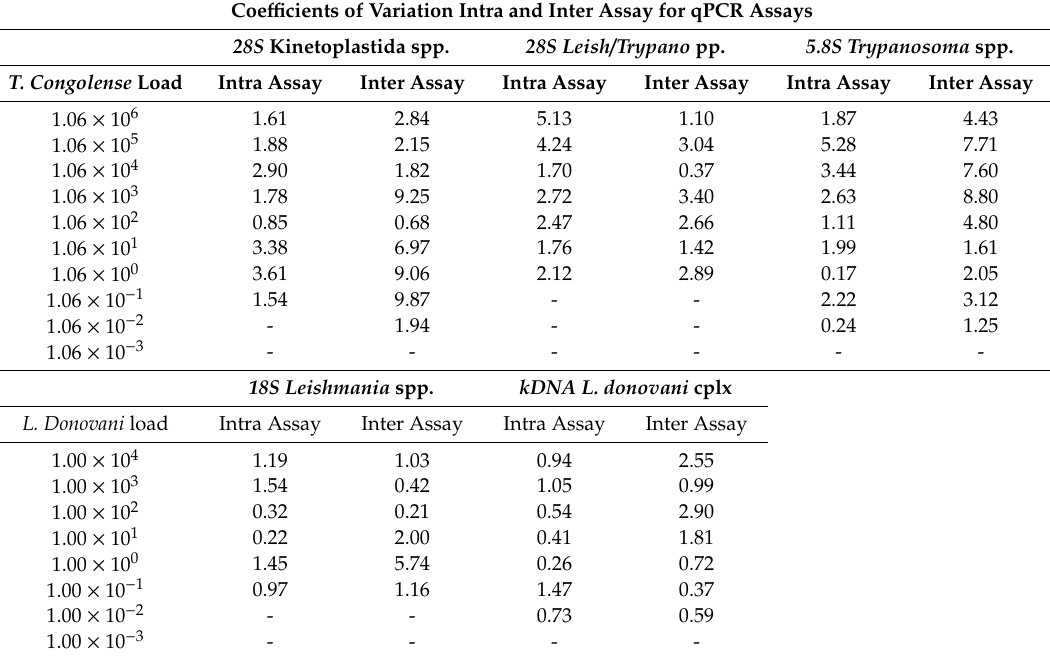
Table 3. Repeatability and reproducibility of the real-time qPCR assays. Coe ffi cients of Variation Intra and Inter Assay for qPCR Assays 28S Kinetoplastida spp. 28S Leish / Trypano